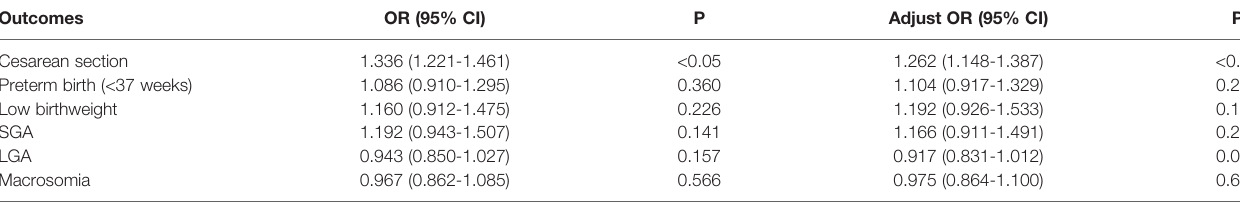
TABLE 3 | Logistic regression analysis of potential confouders e for neonatal outcomes from frozen blastocyst at day 5 or day 6.